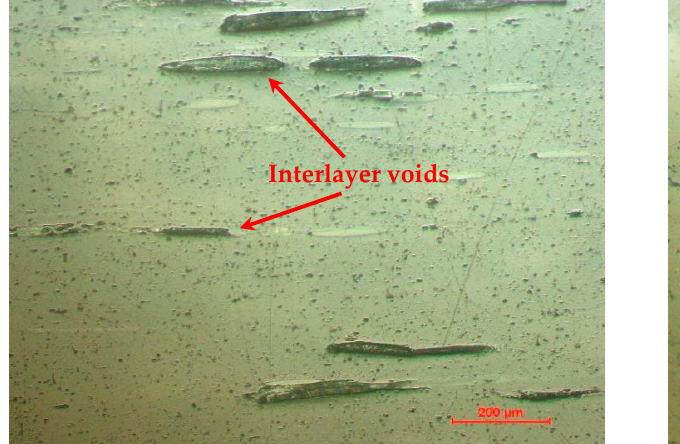
Figure 7. Comparative study of experimental results and FEA results: ( a ) graphical representation of reaction forces; ( b ) graphical representation of FEA stresses.